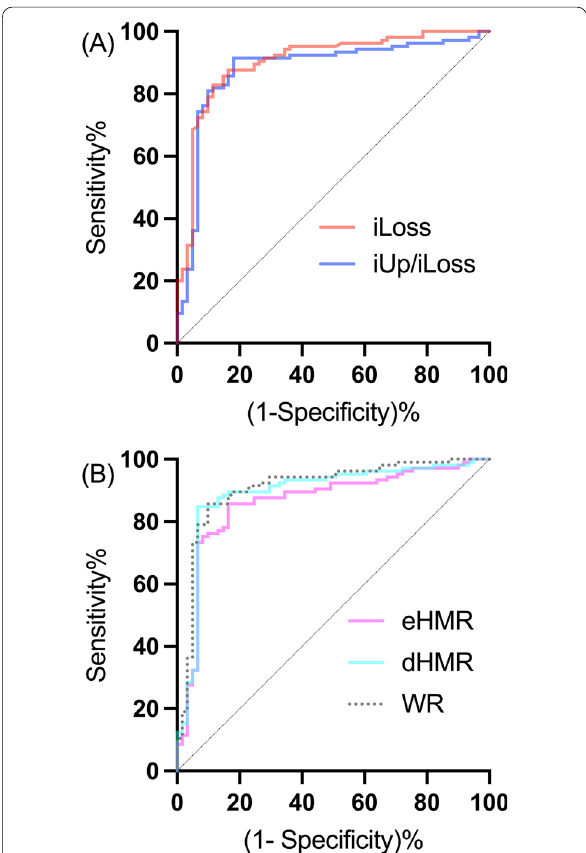
Fig. 4 Receiver operating characteristic (ROC) curves of the new ( A ) and current ( B ) indices of 123 I‑MIBG for identifying patients with Lewy body disease (LBD). ROC analysis was performed for 166 tests (see the demographics of the 105 LBD and 61 non‑LBD patients in Table 3). Areas under the curve (AUCs) are summarized in Table